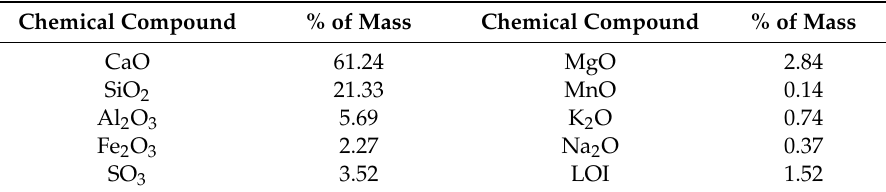
Table 1. Chemical properties of cement.